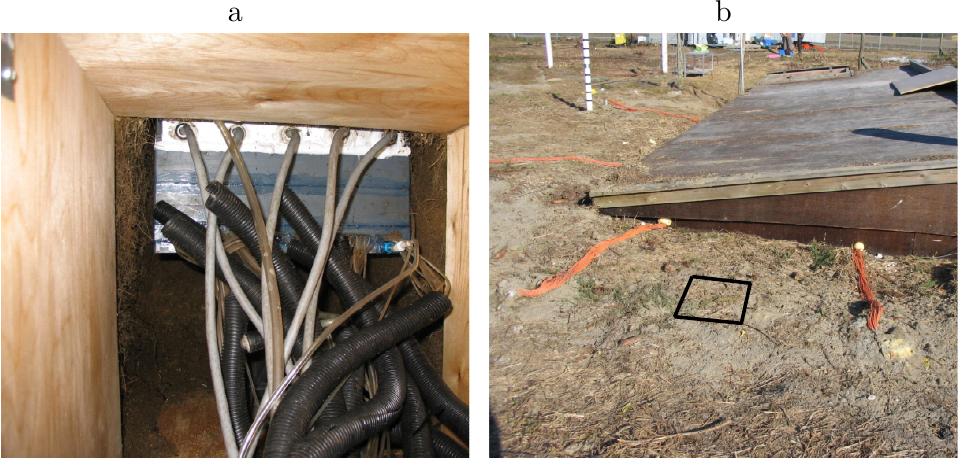
Fig. 1. Experimental setup. Installation of the multi-compartment sampler (MCS), shown from the trench (a) . The location of the MCS